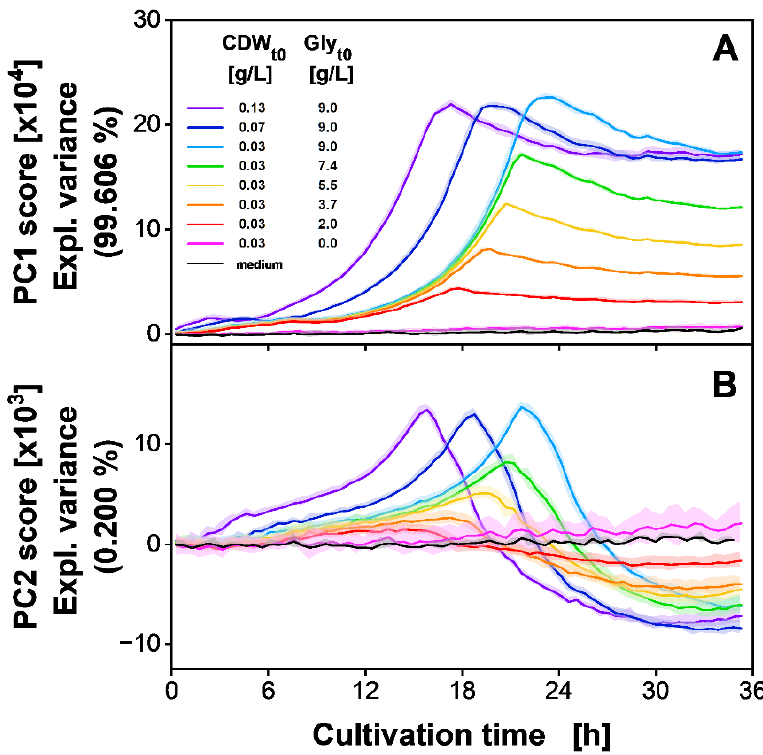
Figure 5. Scores of ( A ) first (PC1) and ( B ) second principal components (PC2) based on 2D spectra of Hansenula polymorpha RB11 pC10- FMD (P FMD -GFP) cultivations in SYN6 medium at eight different initial cell dry weights (CDW t0 ) and glycerol (Gly t0 ) concentrations. Signals show mean scores of six replicates. Standard deviation is shown as light shading. The individual scores are shown in Figure S4C,D. Spectroscopic measurement settings: excitation wavelength range = 280 nm–700 nm (step size = 10 nm), emission wavelength range = 278 nm–720 nm (step size = 0.45 nm), integration time = 30 ms. Cultivation conditions: 48-well microtiter plate with round geometry, liquid volume = 800 µL, shaking diameter = 3 mm, shaking frequency = 1000 rpm, temperature = 30 °C.